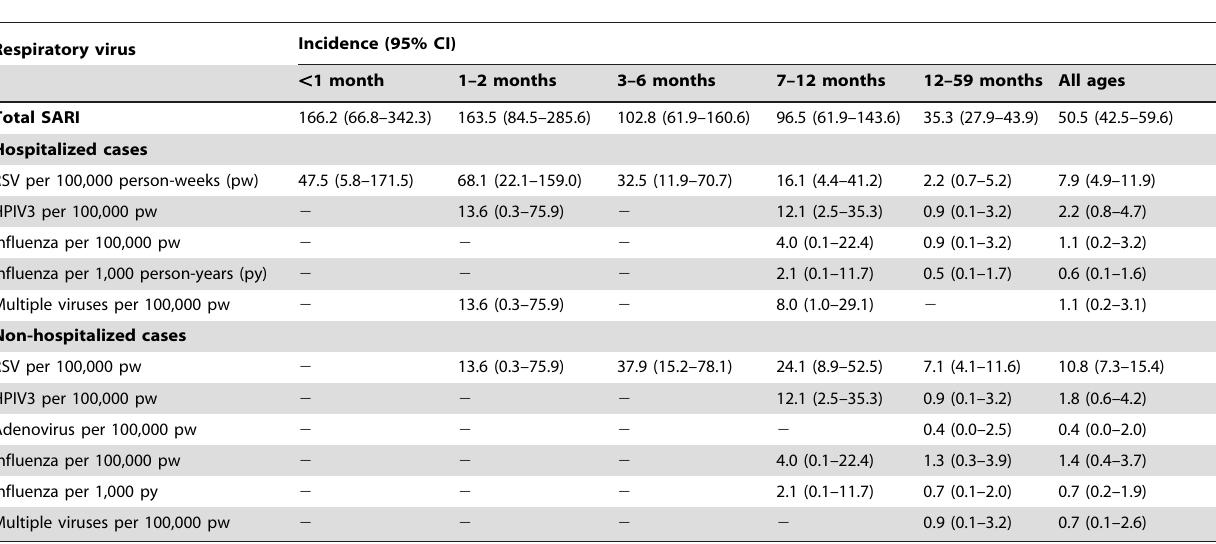
Table 4. Incidences of severe acute respiratory virus infections among children aged , 5 years in Matlab, Bangladesh, June– October